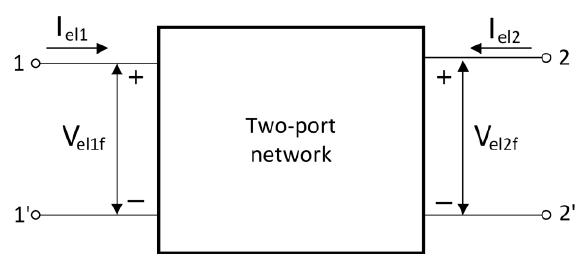
Figure 1. Two-port network model